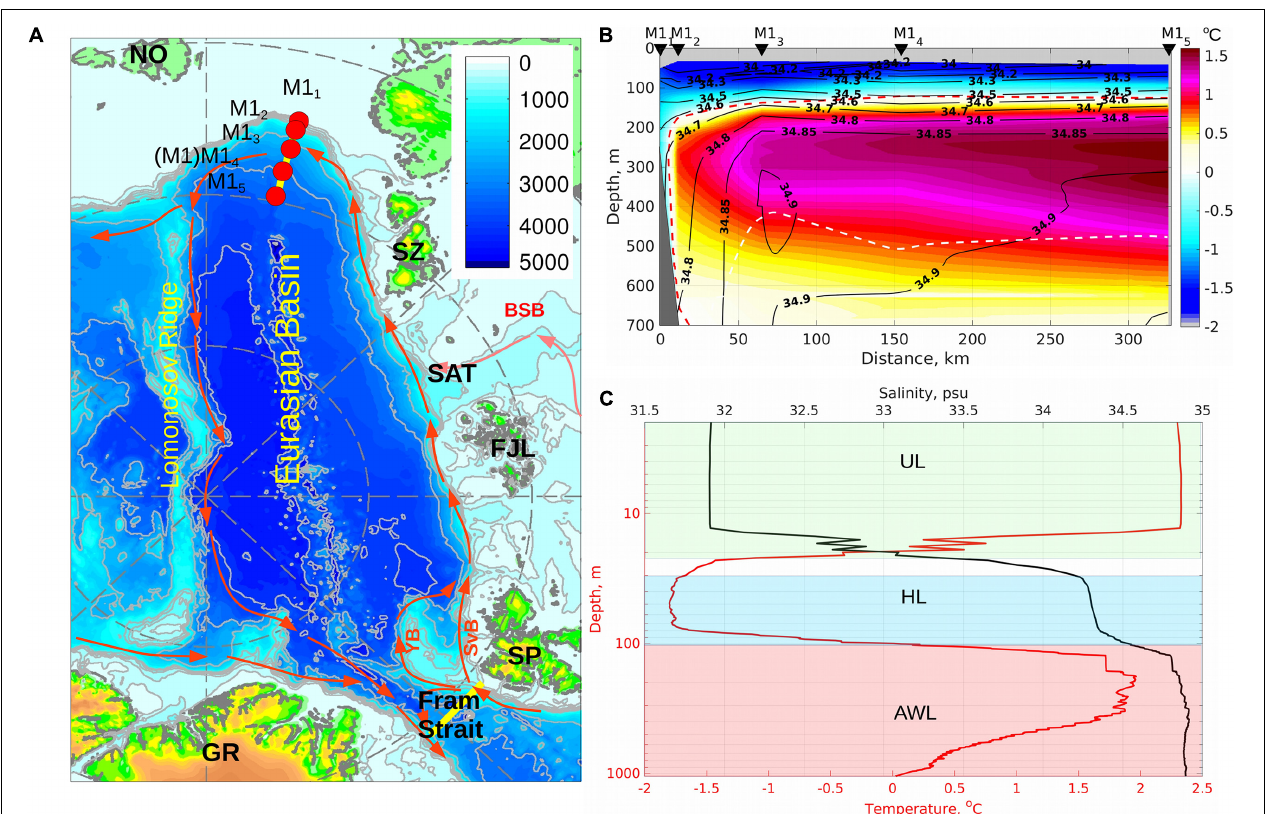
FIGURE 1 | (A) Map showi ng locations of moorings (red circles) over the continental slope of the Laptev Sea in the Eurasian Basin of the Arctic Ocean in 2013–2018. Greenland (GR), Spitsbergen (SP), Franz Joseph Land (FJL), St. Anna Trough (SAT), Severnaya Zemlya (SZ), and Novosibirskiye Islands (NO) are indicated. YB, SvB, and BSB indicate Yermak, Svalbard, and Barents Sea branches of the Atlantic Water (AW), respectively. Red arrows show a schematic pattern of AW circulation in the Eurasian Basin. Bottom depth in meters is shown by color and gray contours (5000, 4000, 3000, 2000, 1000, 800, 600, 400, and 200 m). Sections and moorings used in this study are indicated by yellow segments and red circles. (B) The 2013–2018 mean temperature (color) and salinity (isolines) distributions along the 125 ◦ E section. Gray areas at the cross-slope section indicate layers not covered by mooring-based temperature and salinity observations. Black triangles show the position of NABOS moorings. The dashed red line shows the position of the AW layer boundary identified by 0 ◦ C isotherm. The dashed white line shows the position of the potential density σ = 27.97. (C) Summer CTD temperature and salinity profiles at the M1 4 mooring site in 2018. AWL, HL, and UL show the AW, halocline, and upper layers,